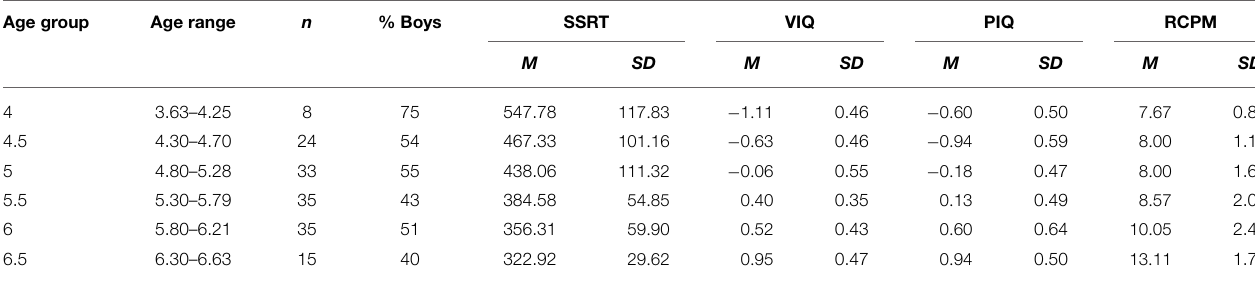
TABLE 2 | Summary of demographic data and performance on the inhibition and intelligence measures. Age